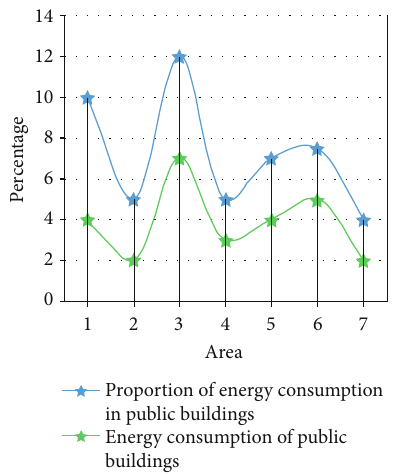
Figure 5: Public building energy consumption and its proportion.